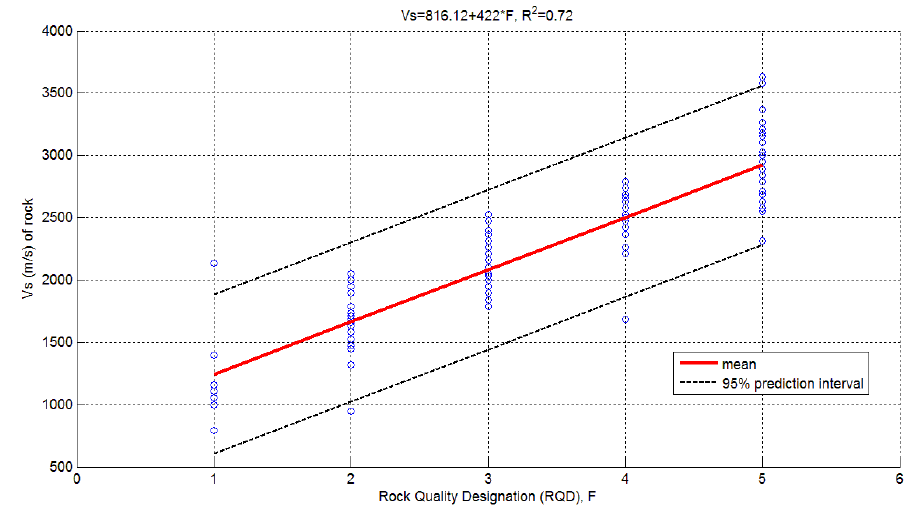
Figure 9. Variation of bedrock Vs (m/s) within the five rock quality designation (RQD) categories. The blue circles indicate the Vs values corresponding to each RQD.